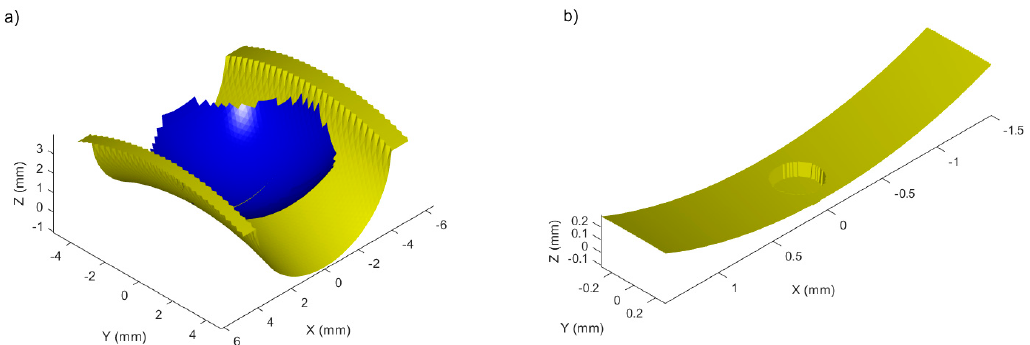
Figure 2. ( a ) Computational model of the inner race and ball. ( b ) Detail of the damaged inner race for a defect size of 0.014 in (0.35 mm).